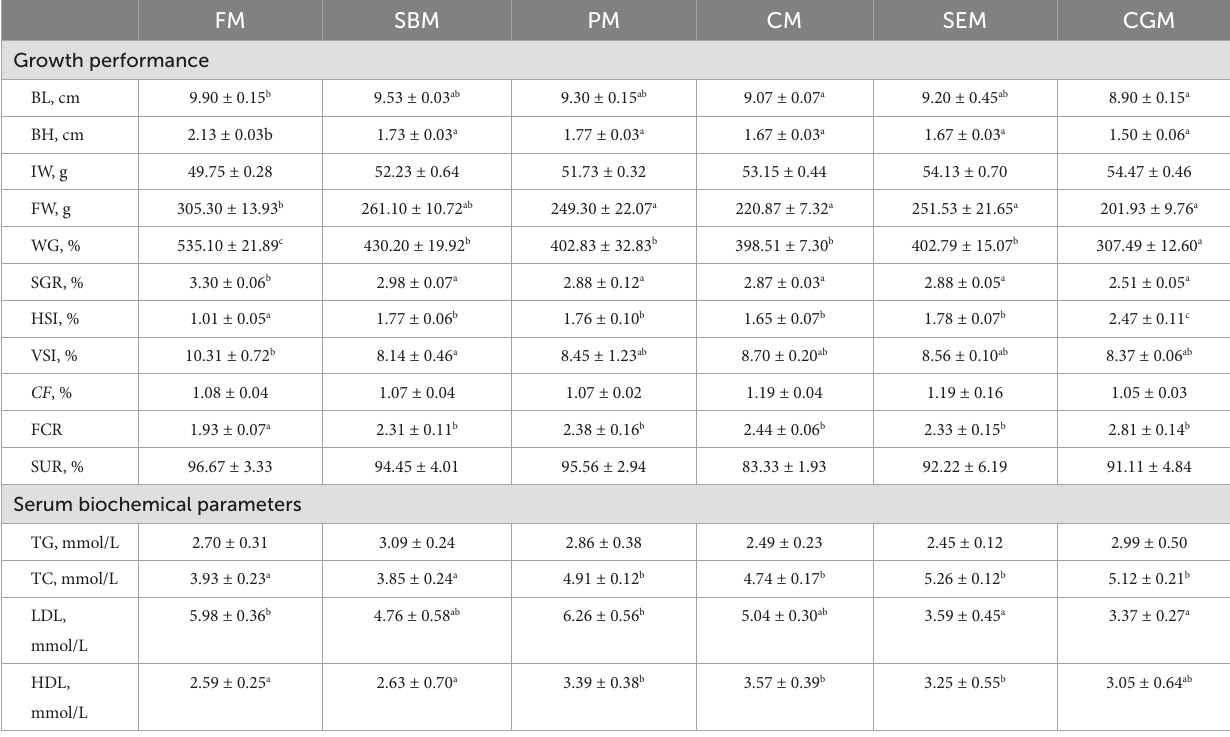
TABLE 3 The effect of five typical plant proteins partially replacing fish meal on the growth performance and serum biochemical parameters of yellow catfish.